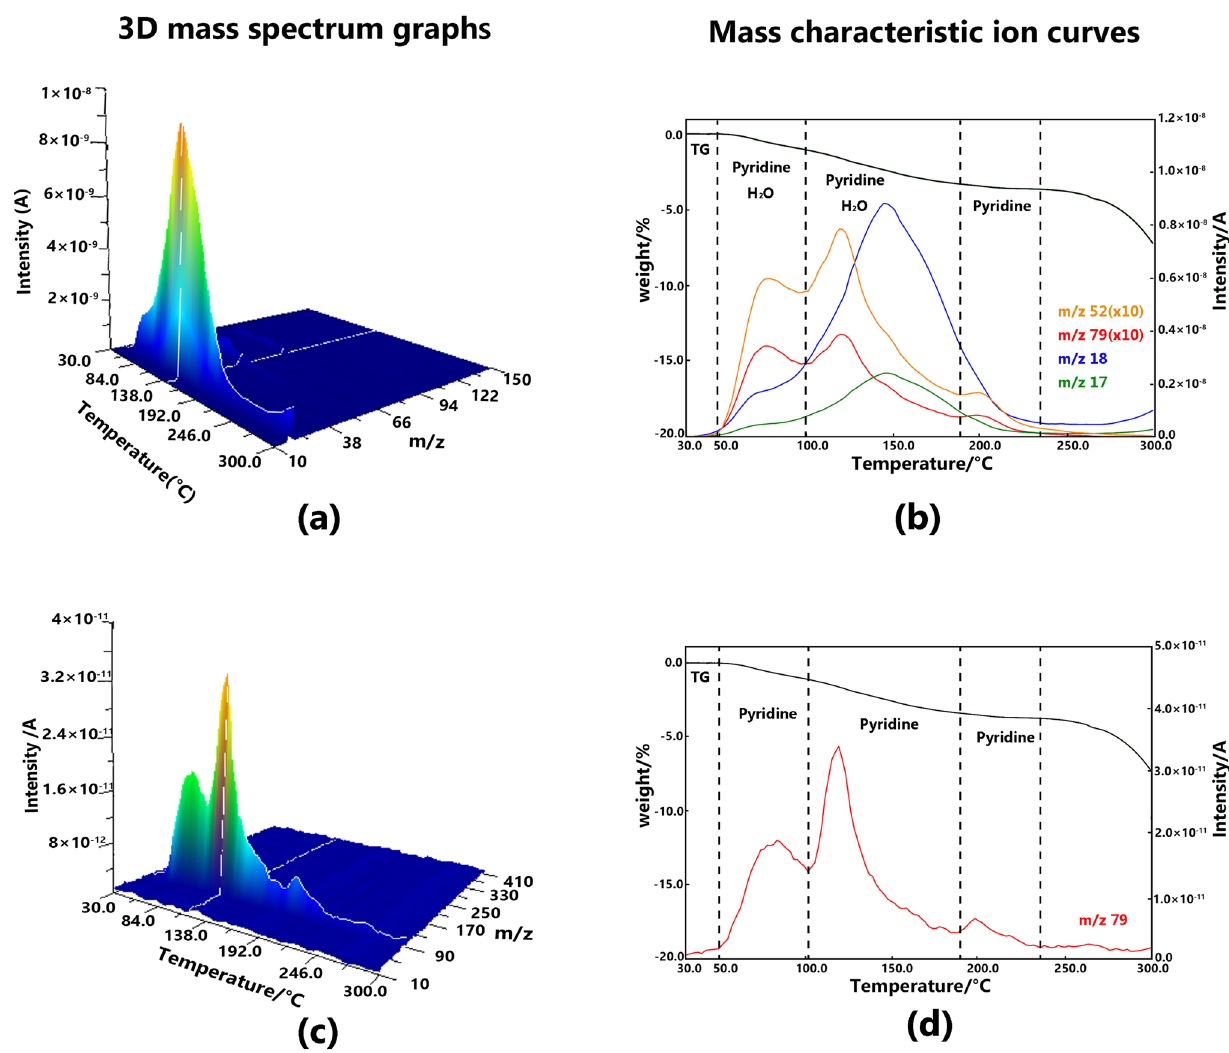
Fig. 3 3D mass spectrum graphs of solvatomorph A measured at EI method ( a ) and PI method ( c ), mass characteristic ion curves solvatomorph A measured at EI method ( b ) and PI method (d) ※ “(× 10)” means that the signal intensity was magnified ten